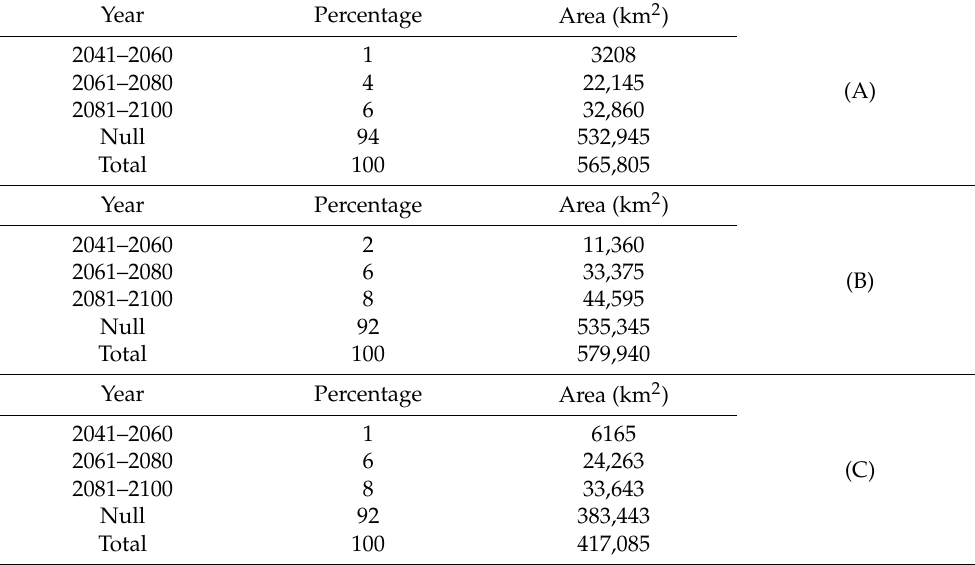
Table 5. Flood area percentages for the scenario Optimistic SSP1-RCP2.6 with the three land uses: (A) agricultural area, (B) urban area, and (C) natural resources